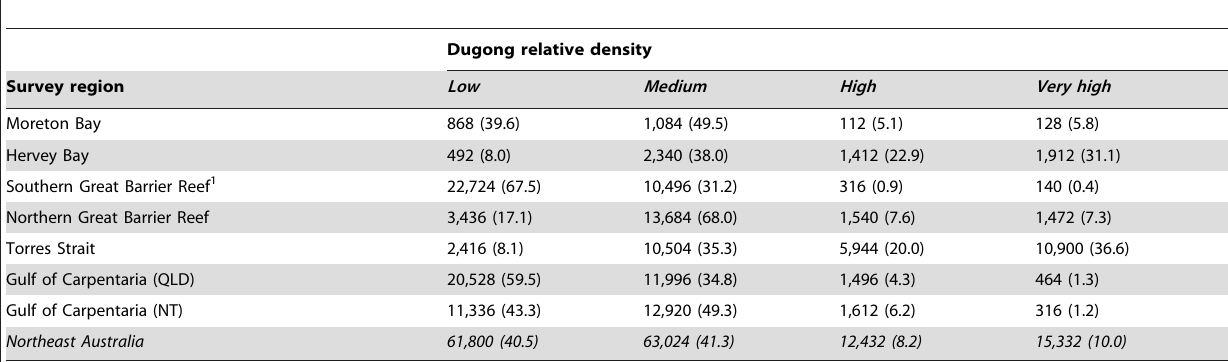
Table 3. Total area (km 2 ) and proportion (%) of dugong planning units of low, medium, high and very high relative densities within the seven survey